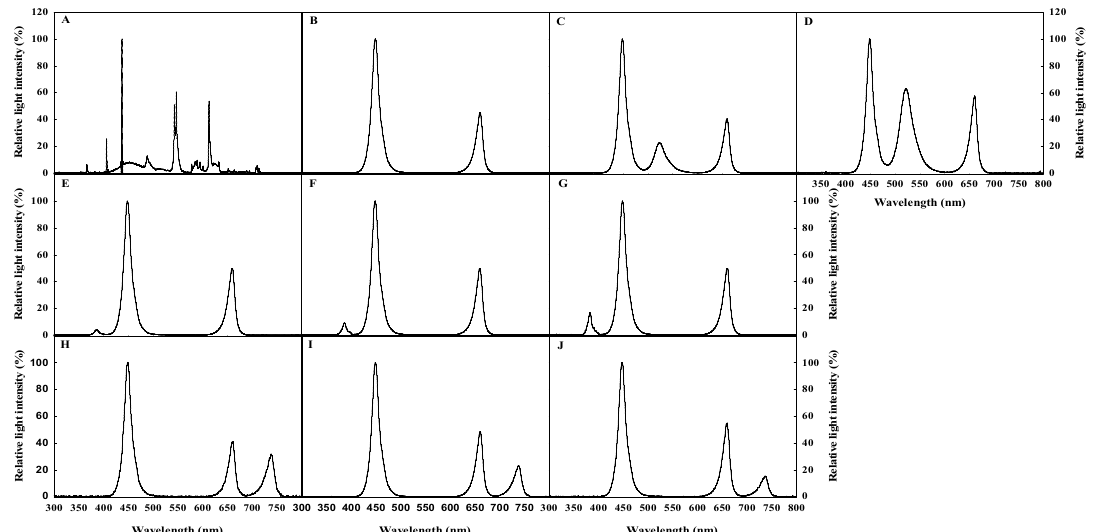
Figure 1. The spectral distribution of lights used in the experiment: A, FL (Fluorescent lamp); B, R3B7 (red:blue = 30:70); C, G20 (red:green:blue = 20:20:60); D, G40 (red:green:blue = 20:40:40); E, UV 0.4 (red:blue = 30:70 + UV-A 0.4 W·m −2 ); F, UV 0.6 (red:blue = 30:70 + UV-A 0.6 W·m −2 ); G, UV 0.8 (red:blue = 30:70 + UV-A 0.8 W·m −2 ); H, Fr1 (red:blue:far-red = 20:60:20); I, Fr2 (red:blue:far-red = 26:60:14); and J, Fr3 (red:blue:far-red = 30:60:10). These ratios of the above light quality were expressed by the ratio of photon flux density of each light quality.